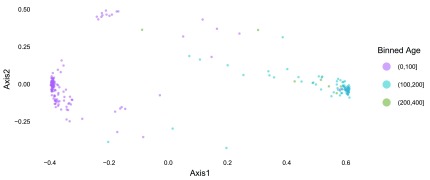
The random forest model determines a distance between samples, which can be input into PCoA to produce a proximity plot.